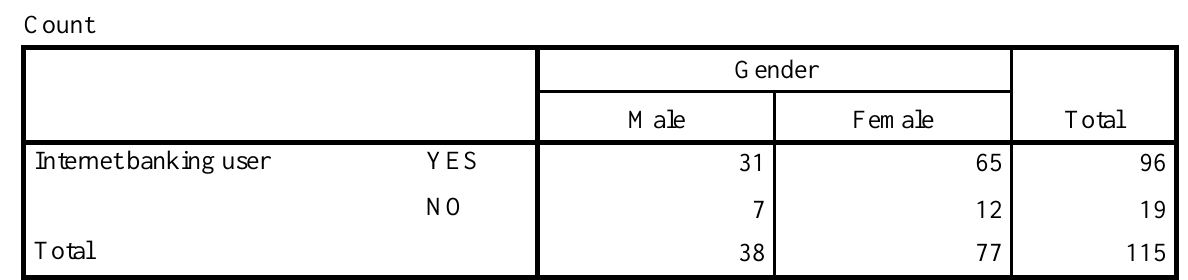
Table 3. Internet banking user vs. gender crosstabulation Crosstabulation